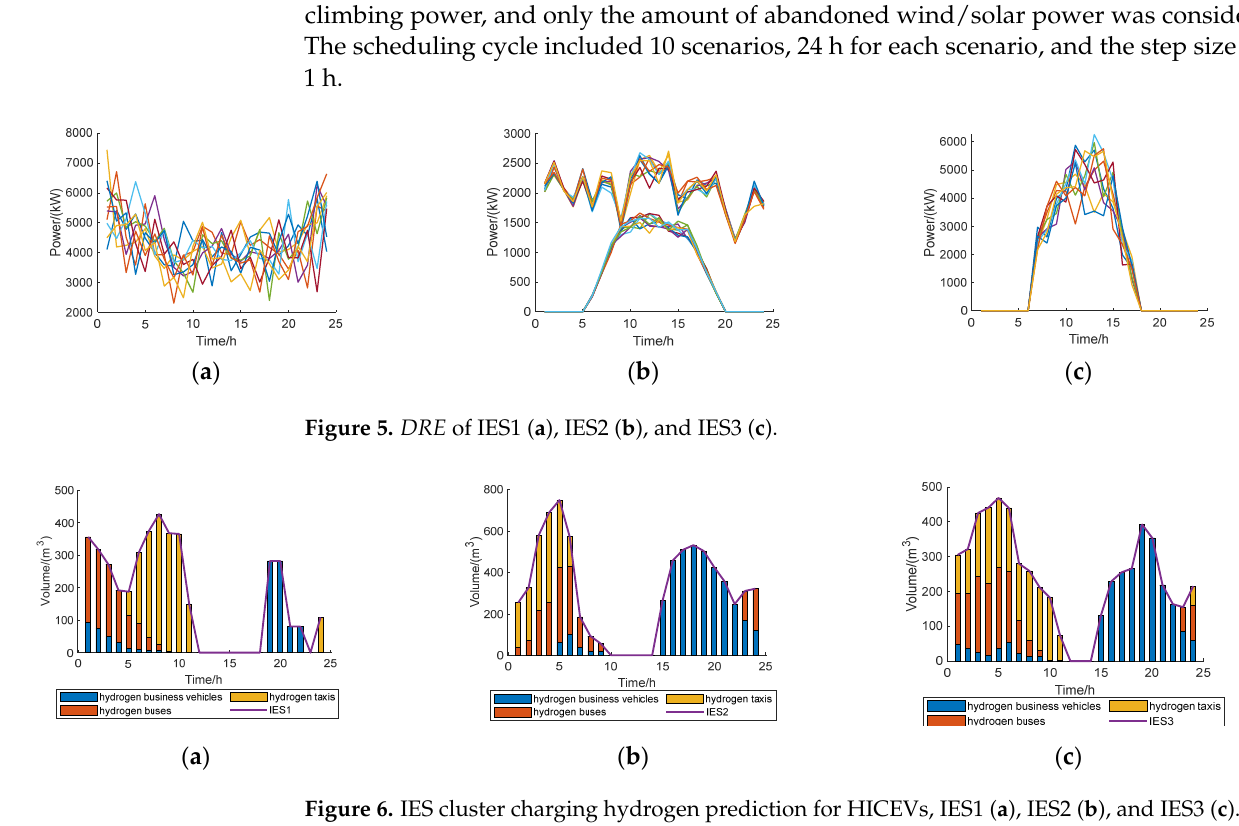
Table 2. Purchase and sale price of the power grid.